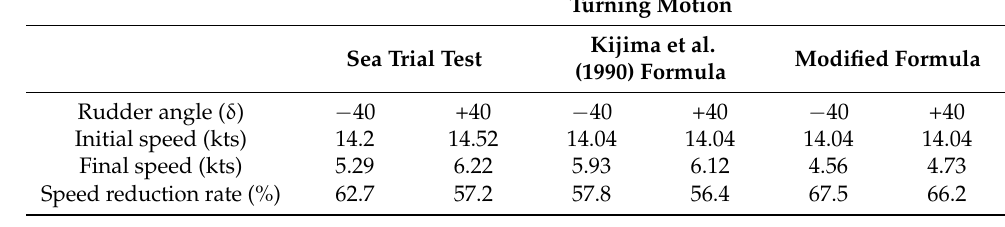
Table 8. Comparison of the speed deceleration rate during the turning motion for the target trawler. Turning Motion Kijima et al. Sea Trial Test (1990) Formula